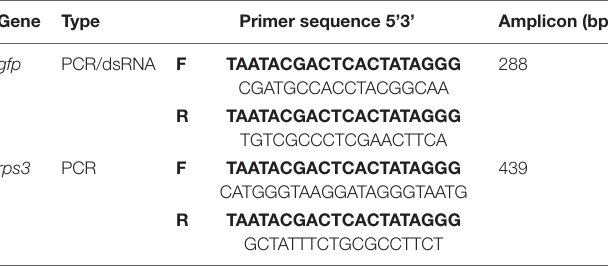
TABLE 1 | Primer sequences for PCR amplification and dsRNA